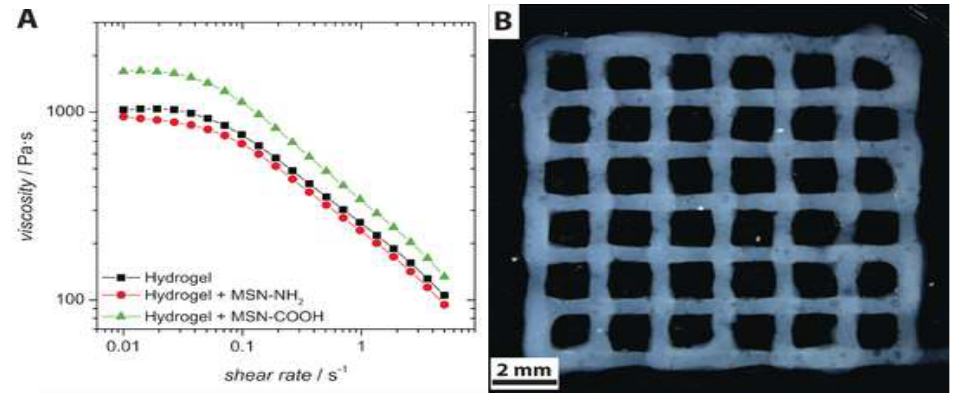
Figure 3. ( a ) Viscosity over shear rate for different systems. ( b ) Stereomicroscopic image showing a Figure 3. ( A ) Viscosity over shear rate for different systems. ( B ) Stereomicroscopic image showing a top view of a four-layer construct (obtained from [57]). top view of a four-layer construct (obtained from